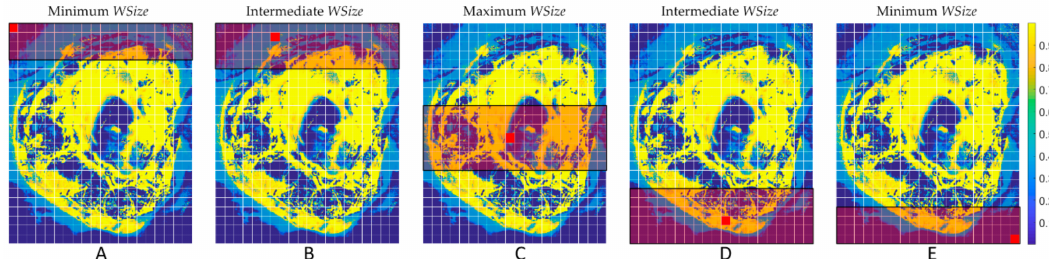
Figure 4. KNN window searching method example. ( A ) Minimum window size of the first pixel; ( B ) Intermediate window size of a pixel near the upper border; ( C ) Maximum window size of a pixel in the center of the image; ( D ) Intermediate window size of a pixel near the bottom border; ( E ) Minimum window size of the last pixel.